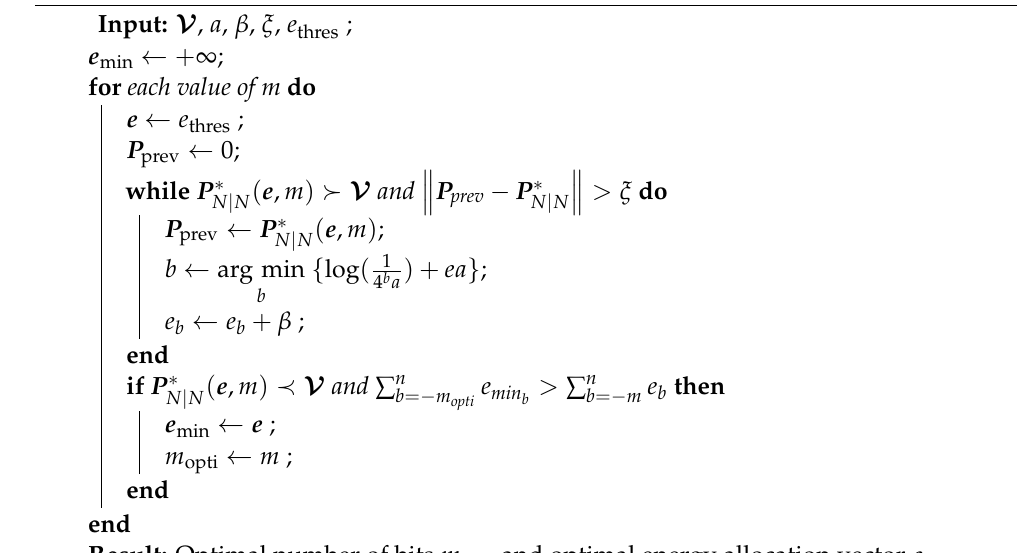
Algorithm 1: Computing the optimal values for e and m